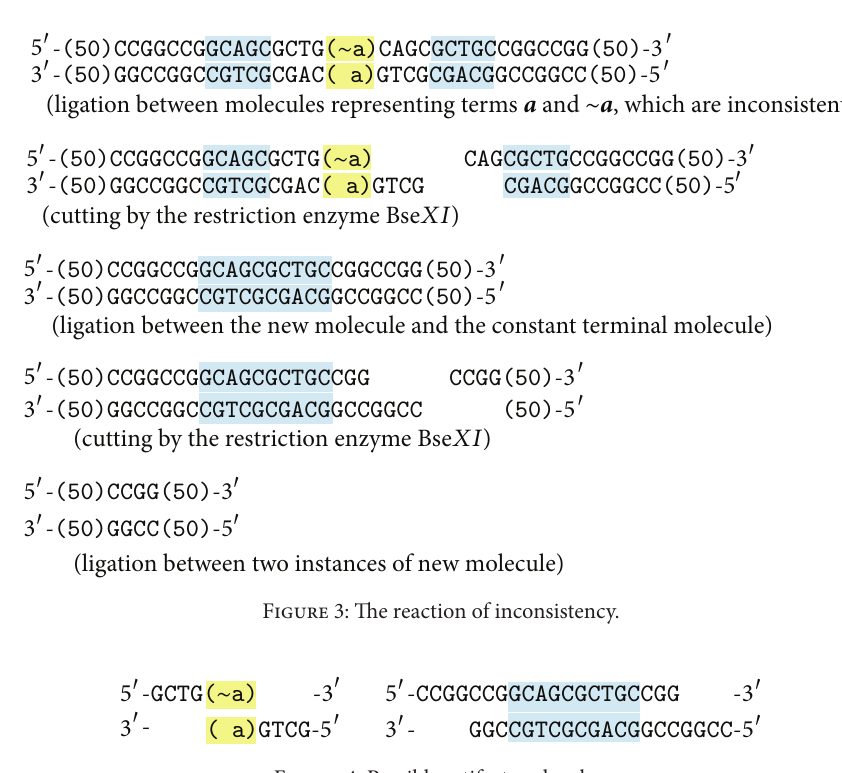
Figure 4: Possible artifact